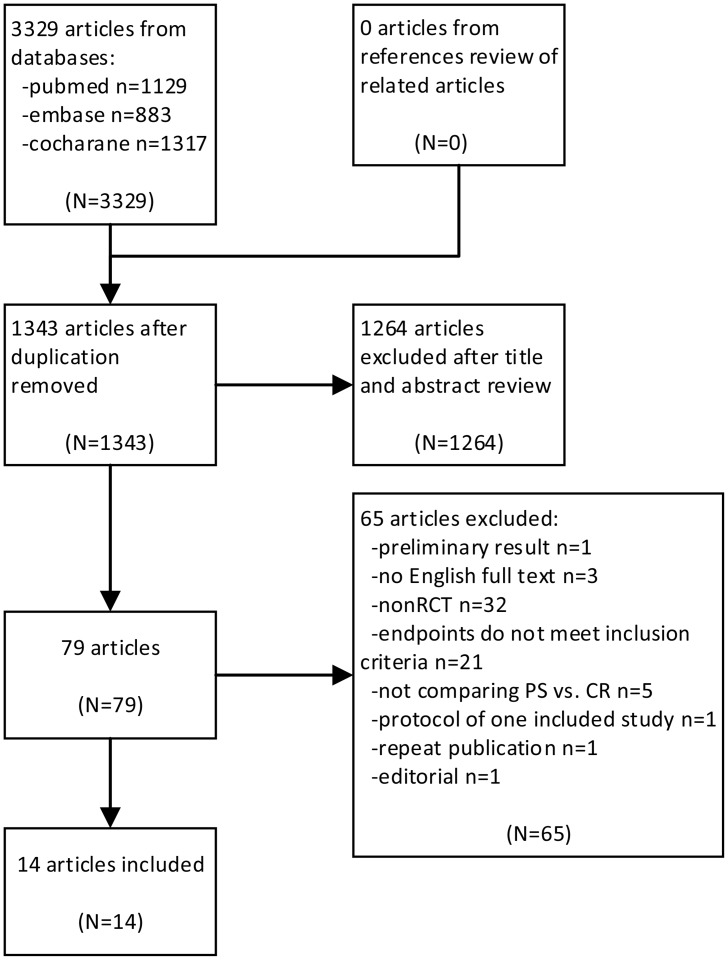
Flow diagram of study selection.